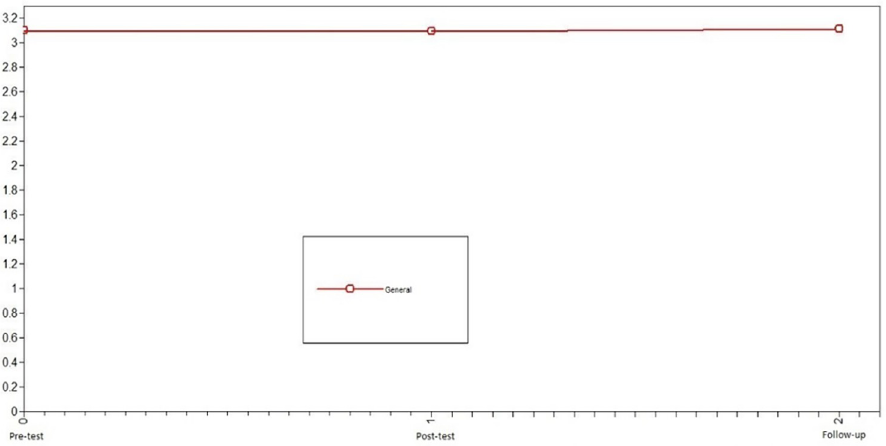
Fig 5. Latent growth curve models of prosocial behavior toward strangers of the control group. The best fit in the control group was the no change model.